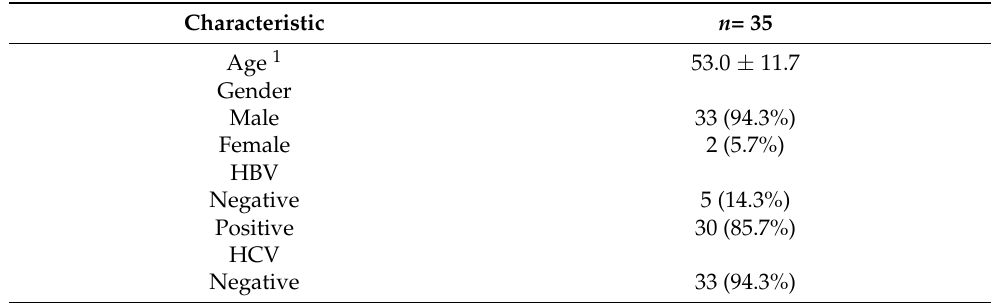
Table 1. Clinical characteristics of 35 advanced HCC patients with TACE refractoriness or